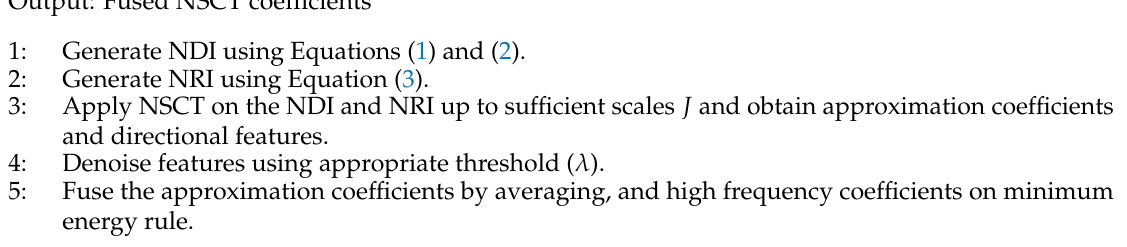
Algorithm 1 NSCT Fusion